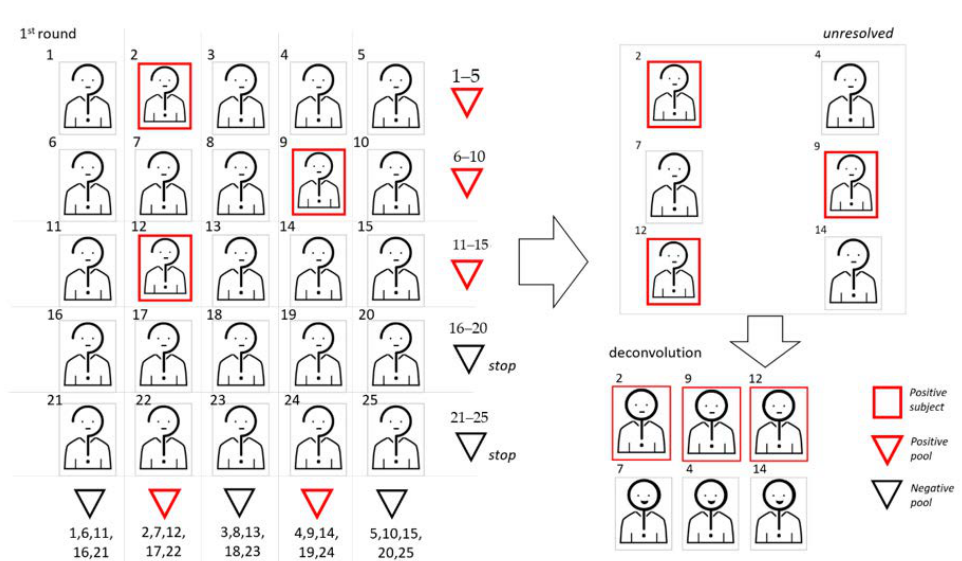
Figure 3. We show a graphic representation of 2D pooling, where samples are arranged on the basis of a symmetric matrix. In this example, the cohort dimension is 25 and the pool size is 5. To begin, samples are used to create 10 pools, 5 following the rows and 5 following the column of the matrix. Samples belonging to at least two positive pools will be retested